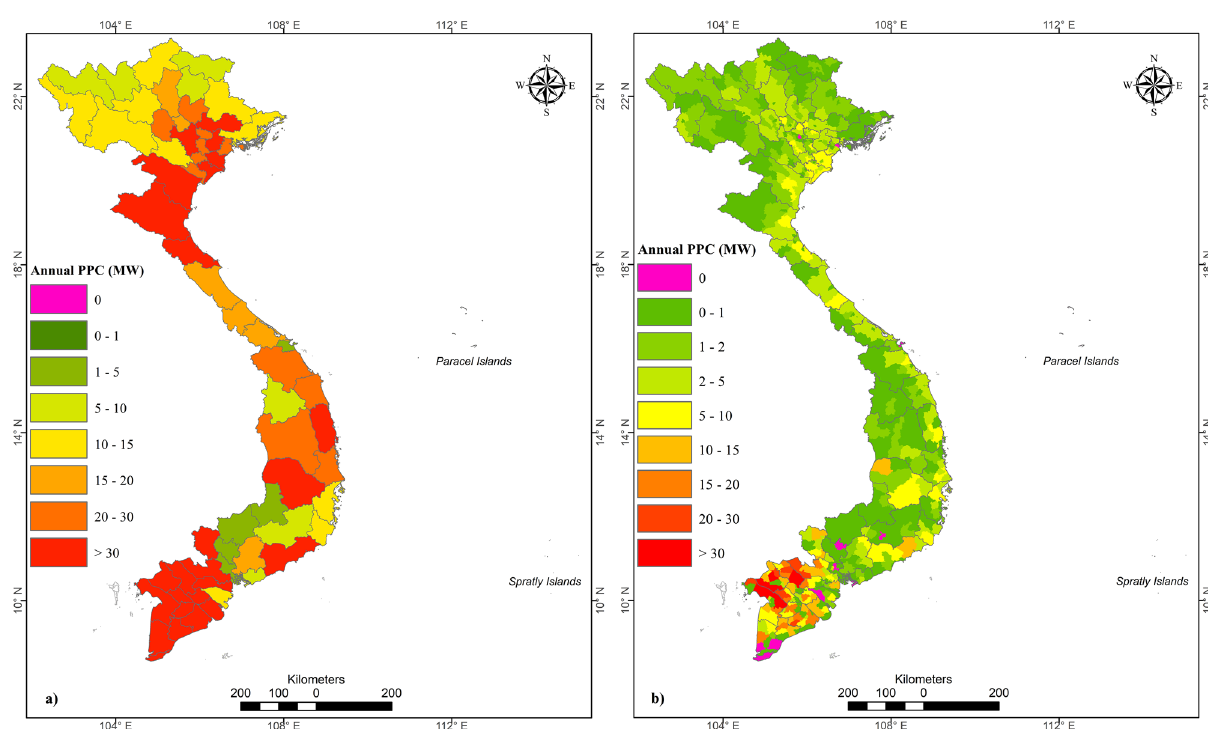
Figure 5. Geographic distribution of power plant capacity based on rice straw at ( a ) provincial and ( b ) district levels in Vietnam, 2019. This map was generated using ArcGIS version 10.2 (https ://deskt op.arcgi s.com/en/ arcma